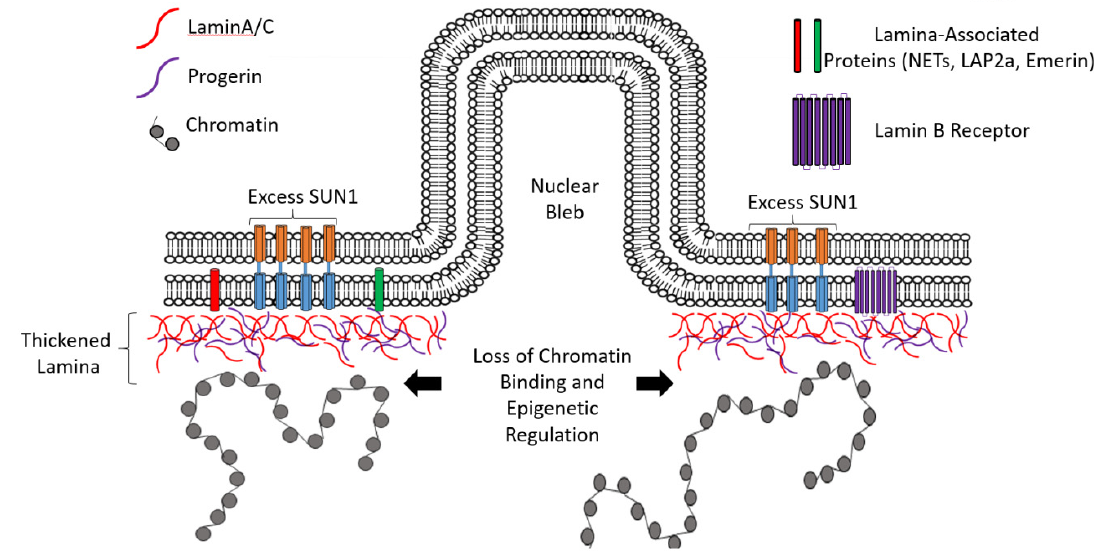
Figure 3. Schematic representation of lamin disruption in Hutchinson–Gilford Progeria Syndrome (HGPS) cells. Nuclear lamina structure becomes thickened with lamin A/C proteins (red lines) in addition to progerin (purple lines). This thickening blocks chromatin (gray spheres) interactions with NETs (red and green cylinders) and Lamin B receptors (purple cylinders). Excess SUN proteins may also accumulate in HGPS cells (blue and orange cylinders). Nuclear blebs form that have large gaps in the lamina structure.